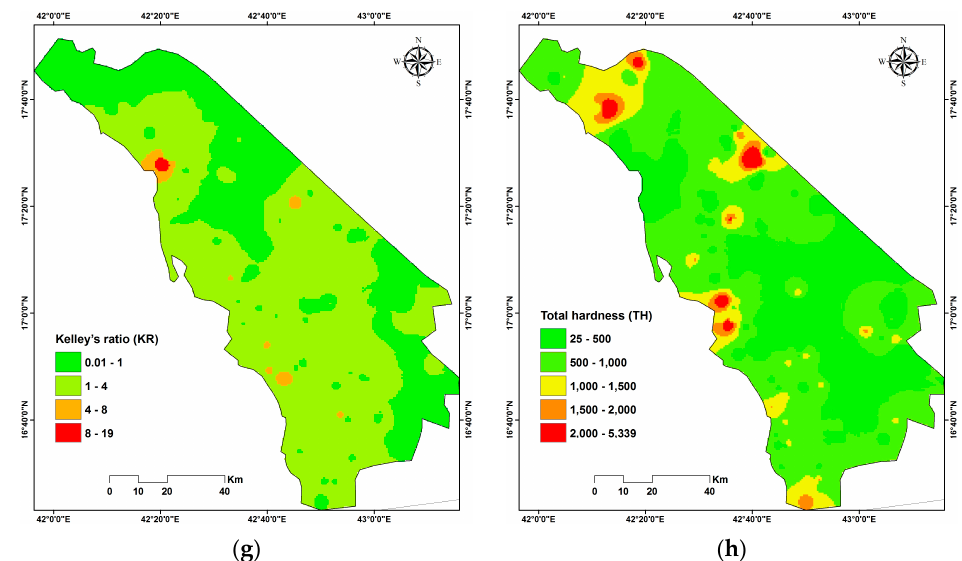
Figure 3. Special distribution for water quality indices: ( a ) EC; ( b ) the sodium percentage (Na%); ( c ) sodium adsorption ratio (SAR); ( d ) permeability Index (PI); ( e ) potential salinity (PS); ( f ) magnesium hazard (MH); ( g ) Kelley’s ratio (KR); ( h ) total hardness (TH).